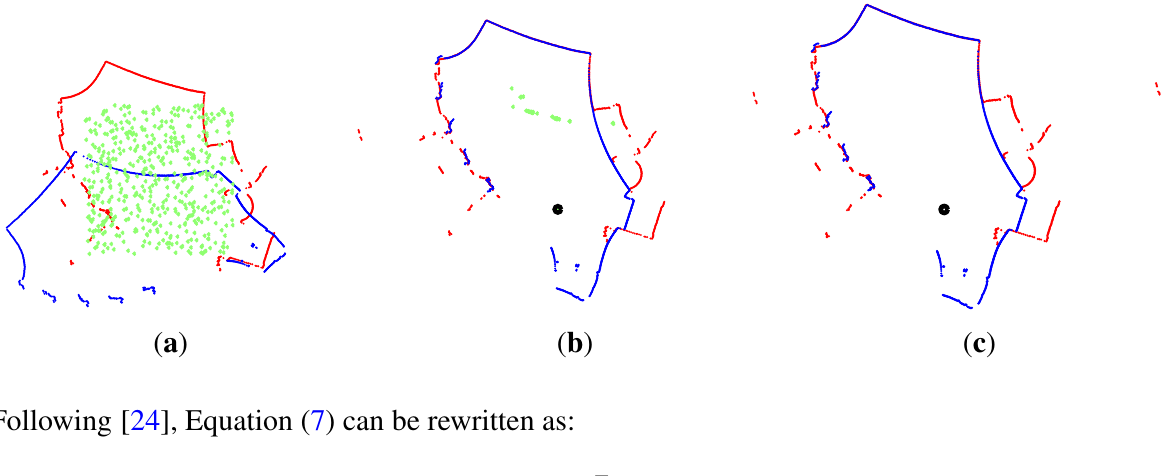
Figure 11. An example of the FGSM process. The scans are shown in red and blue while the chromosomes are shown in green. A black circle denotes the location of the best chromosome in the population. ( a ) The initial chromosome sampling. ( b ) After a few generations the chromosomes have converged to a subset of the local minima. ( c ) After enough generations have passed the population has converged to a single dominant